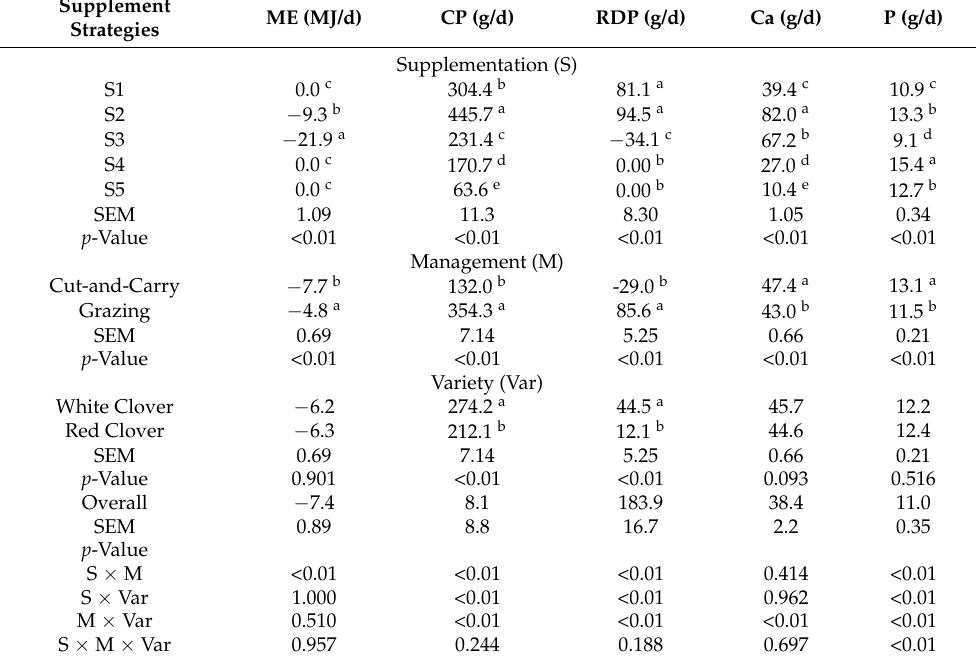
Table 6. Balance (g/d) and metabolizable energy (MJ/d) of different strategies, five different simu- lated supplementations (S) in dairy cattle grazing under two feeding strategy systems management (grazing vs. cut-and-carry), and two legume varieties (red clover or white clover). Supplement ME (MJ/d) CP (g/d) Strategies